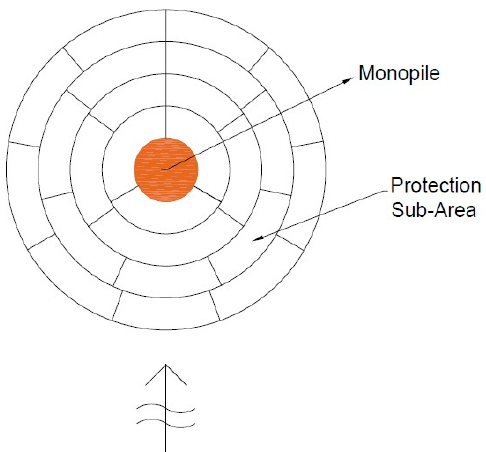
Figure 1. Scheme of the sub-area divisions used in Reference [23].